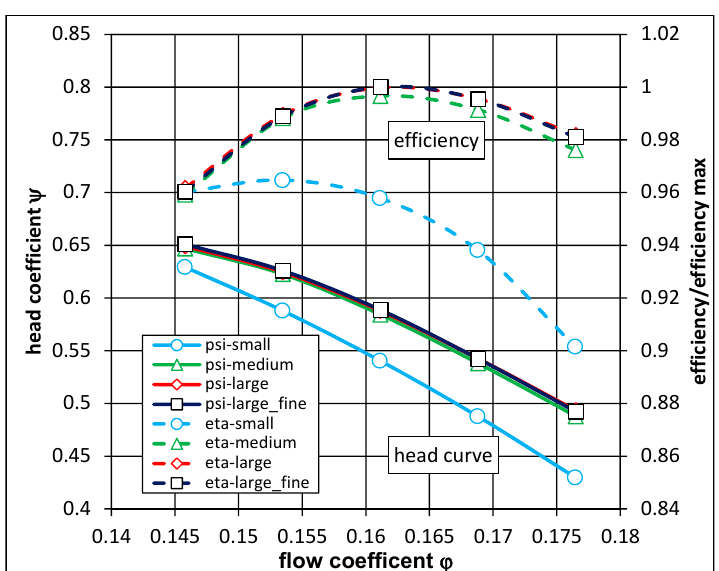
Figure 5. Results for different grid sizes on head coefficient and normalized efficiency.